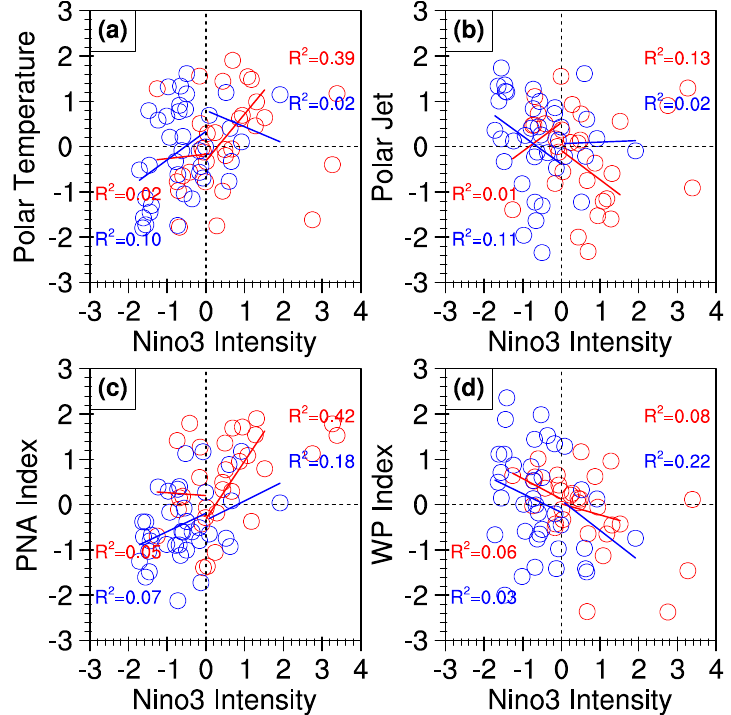
Figure 8. Scatterplots of the normalized winter Niño3 index versus four indicators: ( a ) the normalized winter T pole , ( b ) the normalized winter U pole , ( c ) the normalized winter PNA index, and ( d ) the normalized winter WP index when the PDO is in its positive (red) and negative (blue) phases. Blue/Red lines present the linear relationships between the winter Niño3 index and each of the four indicators when the PDO is in its positive/negative phase. Note that the warm and cold ENSO states are separately checked. The percentage of variance explained by Niño3 ( R 2 ) is printed in each plot for different ENSO/PDO configurations. The sample sizes for the four configurations are 20 (El/P, R 2 ≥ 0.13 for α ≤ 0.1), 7 (El/N, R 2 ≥ 0.38 for α ≤ 0.1), 11 (La/P, R 2 ≥ 0.25 for α ≤ 0.1), and 31 (La/N, R 2 ≥ 0.09 for α ≤ 0.1).